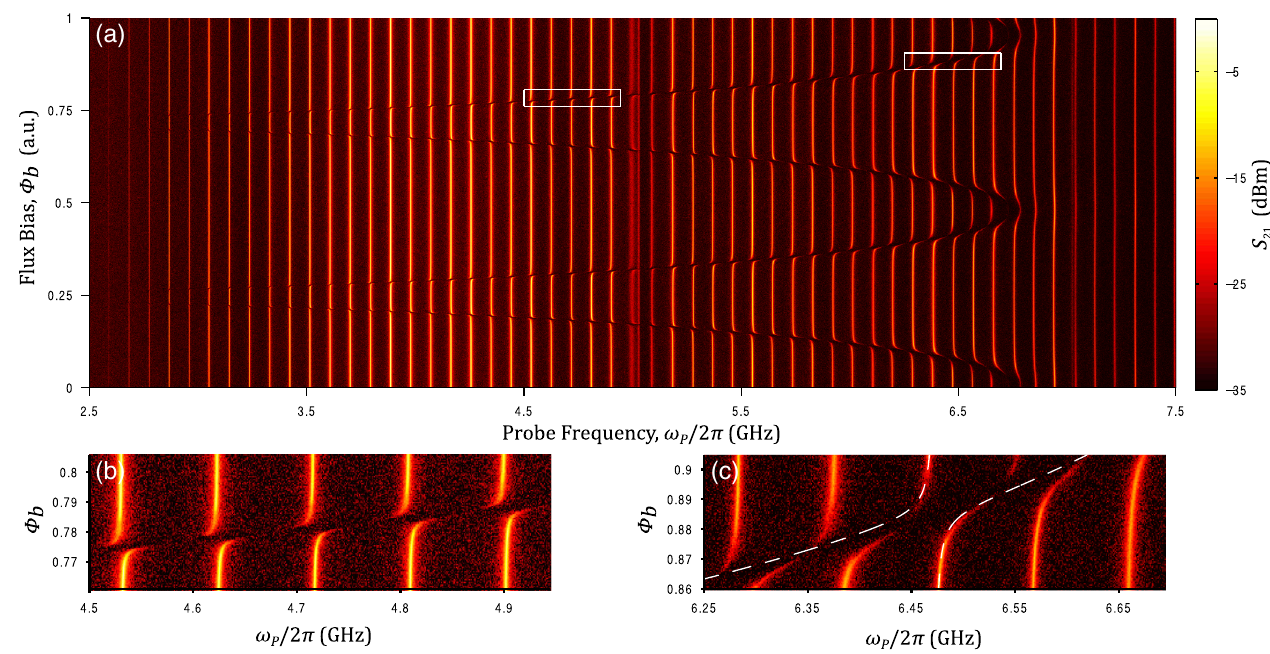
FIG. 2. Demonstrating multimode strong coupling. (a) Low power cavity transmission as qubit frequency is tuned with an applied flux bias. Vacuum Rabi avoided crossings are visible as the qubit is tuned into resonance with each mode (bright vertical lines spaced by approximately 92 MHz). It is apparent that the vacuum Rabi splitting is comparable with the free spectral range (mode spacing), thus indicating that MMSC has been achieved. White rectangles are shown in (b) and (c). The coupling g single-mode fit of the splittings (white dashed line) is not accurate, as evidenced by the strongly shifted states near the central avoided crossing. A fit to the first manifold of the multimode Jaynes-Cummings incorporates all nearby polariton states, yielding g 0 ∼ 3 . 75